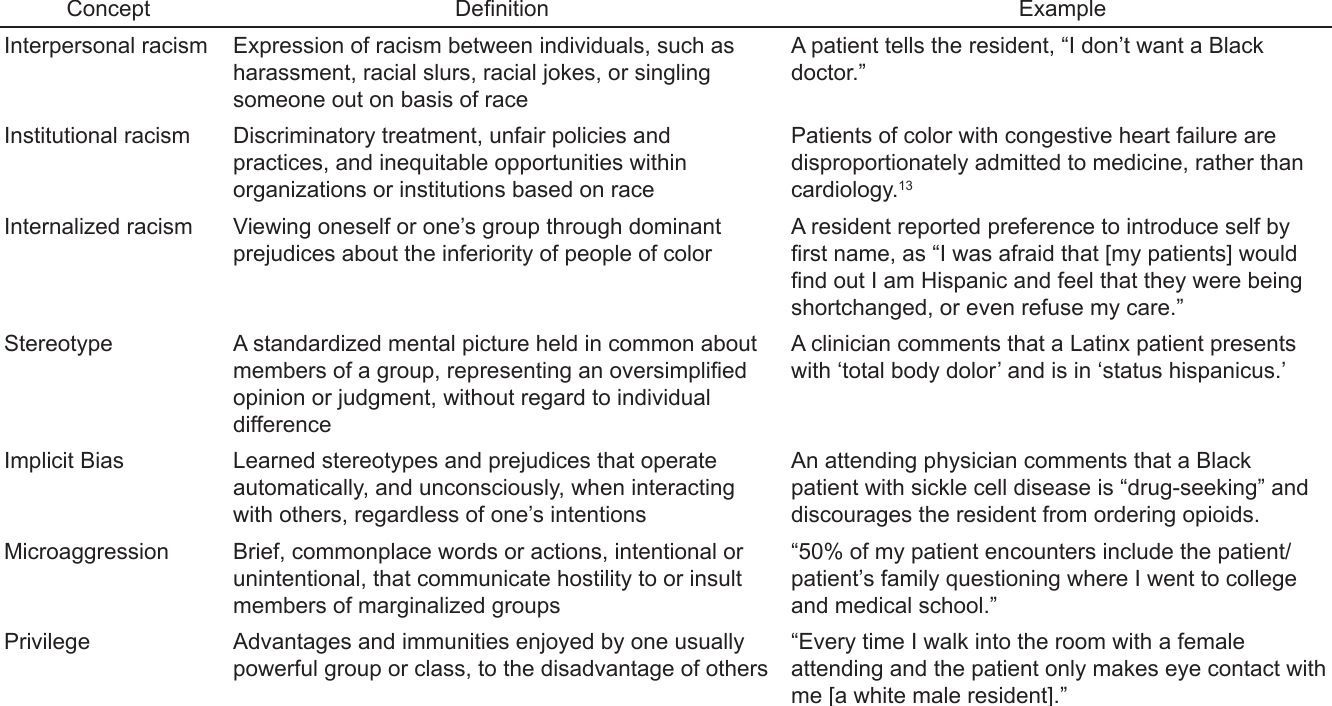
Table 1. Key concepts of racism illustrated through resident